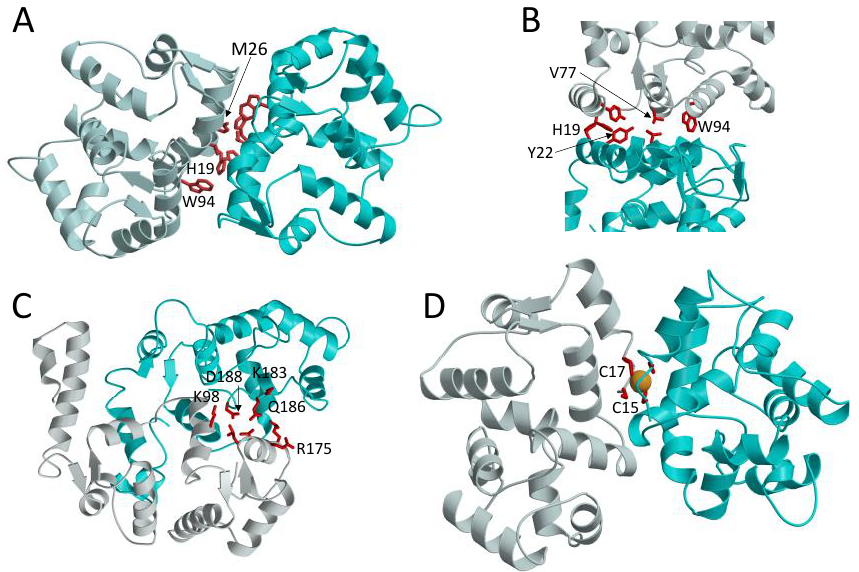
Figure 5. Dimeric structures of GCAP1 ( A ), GCAP2 ( C ), and GCAP5 ( D ). A close-up view of the GCAP1 dimerization site ( B ) reveals intermolecular contacts between aromatic residues (red). The GCAP2 dimerization site is stabilized by intermolecular salt bridges and hydrogen bonds (highlighted by red residues in panel ( C )). The GCAP5 dimerization site is stabilized by a bound Fe 2+ (orange sphere) that is chelated by C15 and C17 ( D ).